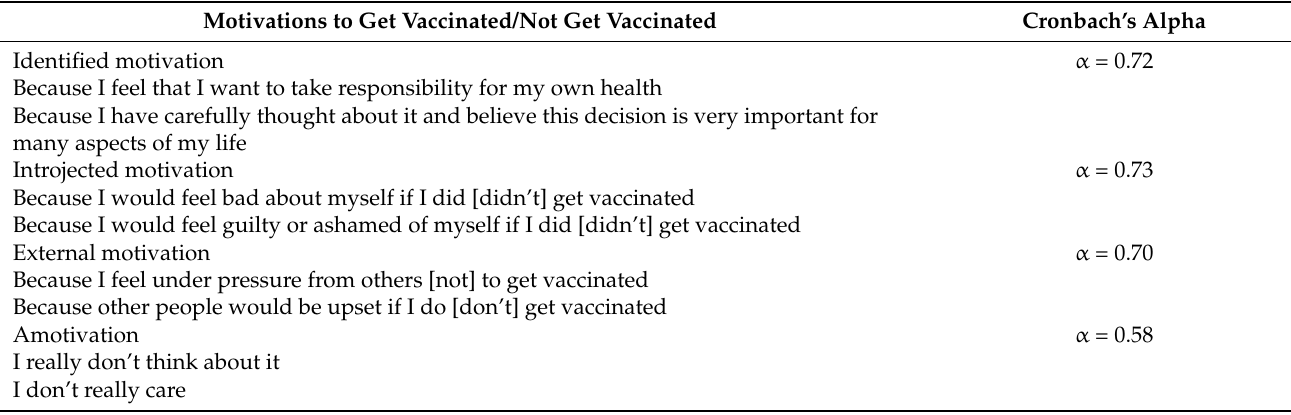
Table 2. The items for the 4 types of motivation, including their Cronbach’s alpha coefficient of reliability. Motivations to Get Vaccinated/Not Get Vaccinated